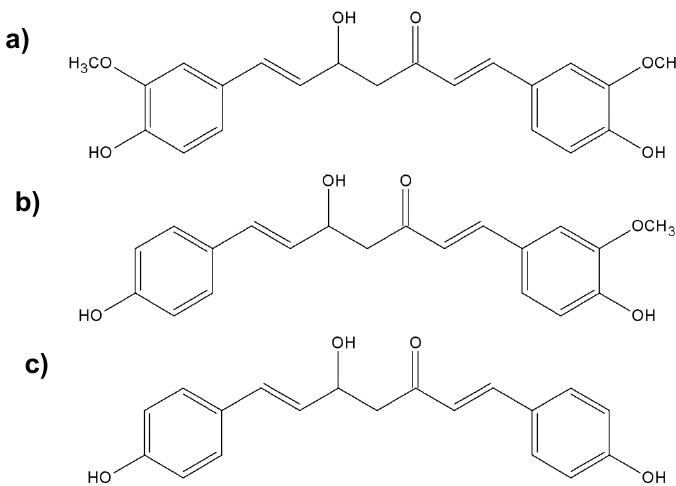
Figure 8. Chemical structures of the nonvolatile important components of turmeric; ( a ) diferuloylmethane; ( b ) desmethoxycurcumin; ( c ) bisdesmethoxycurcumin.